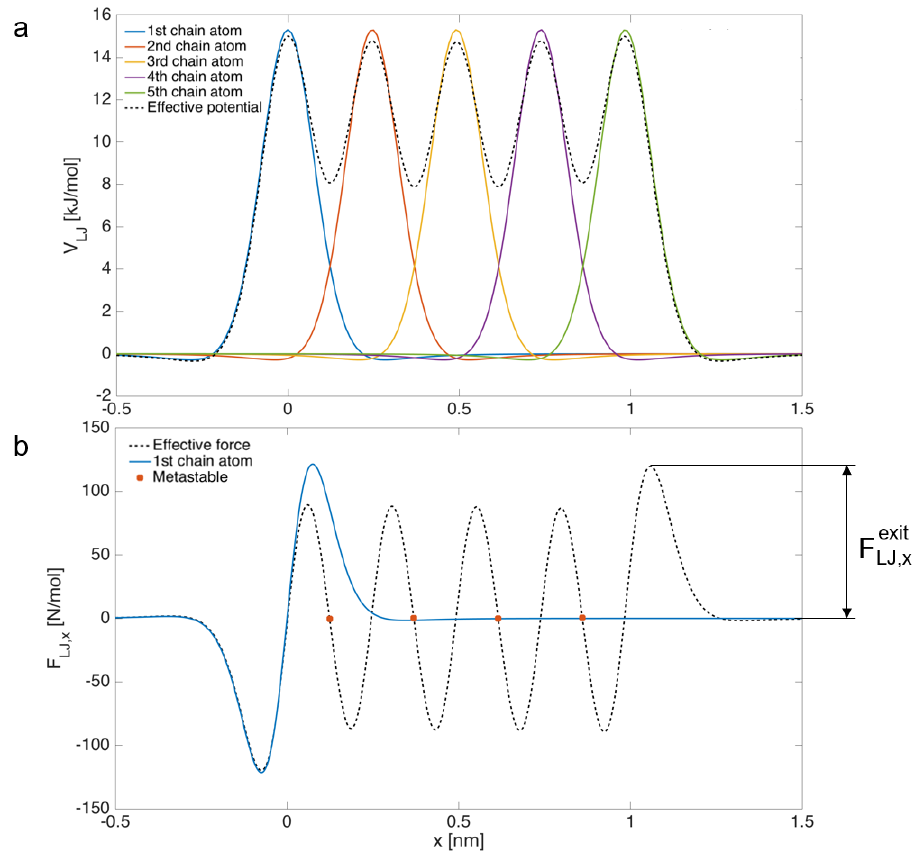
Figure 3. ( a ) Interatomic vdW potential between one carbon atom and a chain of carbon atoms. The effective potential (dashed line) is computed from the superimposition of all interactions between the sliding atom and the atoms of the stationary chain (colored lines); ( b ) VdW force exerted by the carbon chain on the sliding atom along the x direction: the effective force (dashed line) and contribution given by the first atom of the chain (colored line). Orange dots correspond to metastable equilibrium